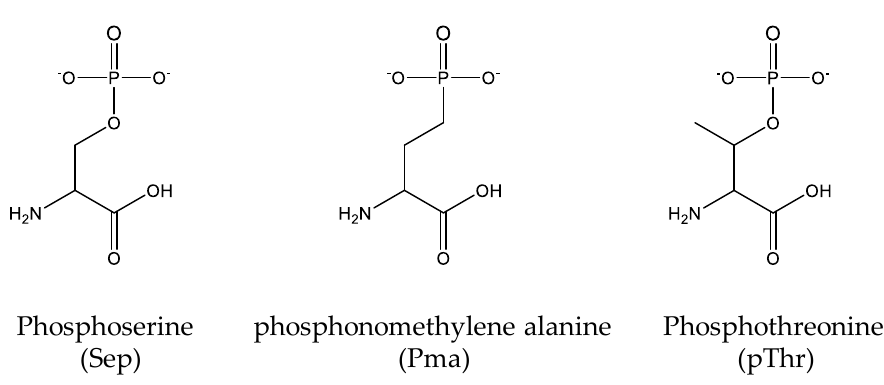
Figure 6. The structures of phosphoserine (Sep), its nonhydrolyzable analog phosphonomethylene alanine (Pma) and phosphothreonine (pThr).